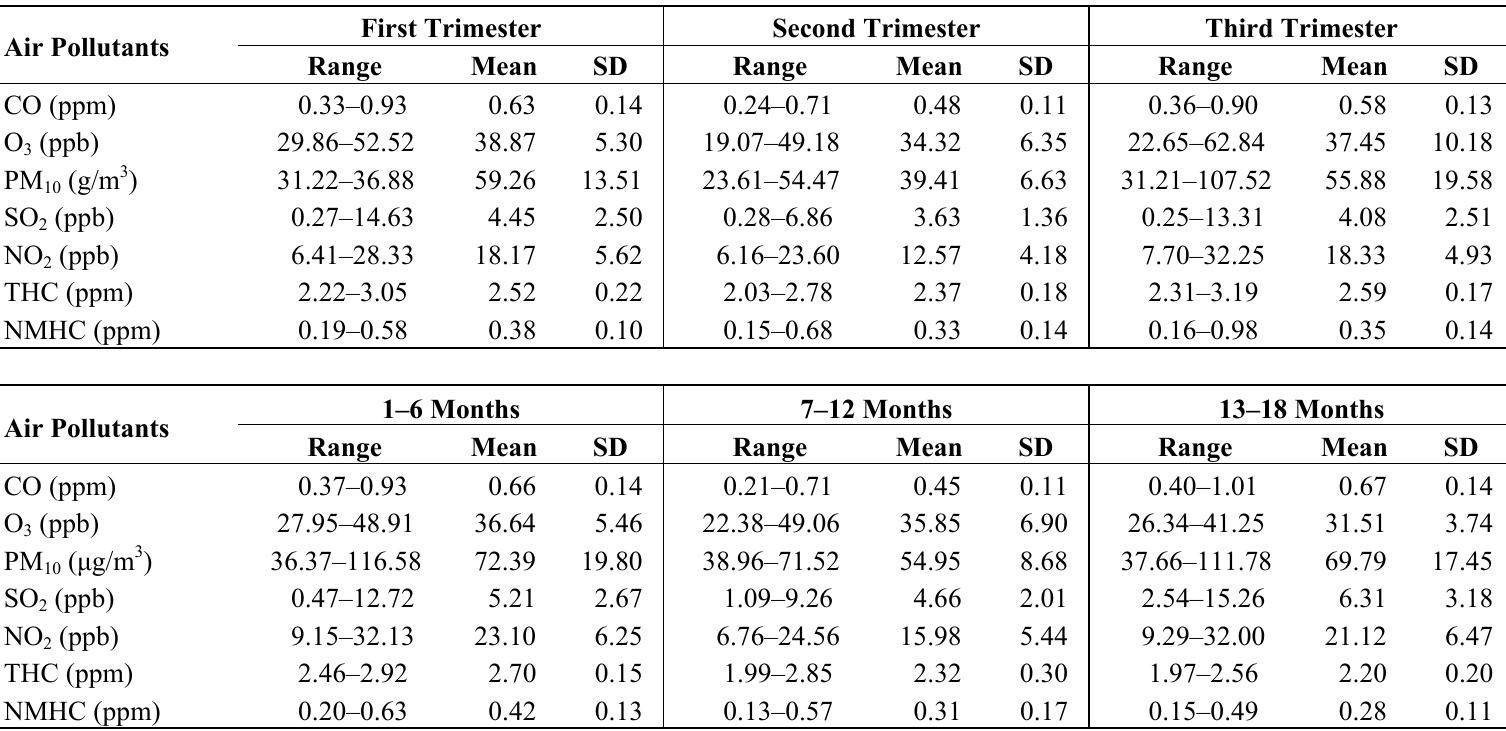
Table 2. Mean and standard deviations of air pollutant concentrations at different